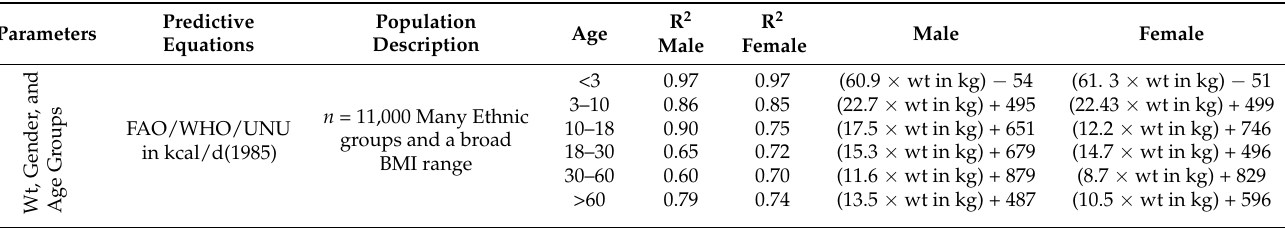
Table 1. Equations for Human Resting Metabolic